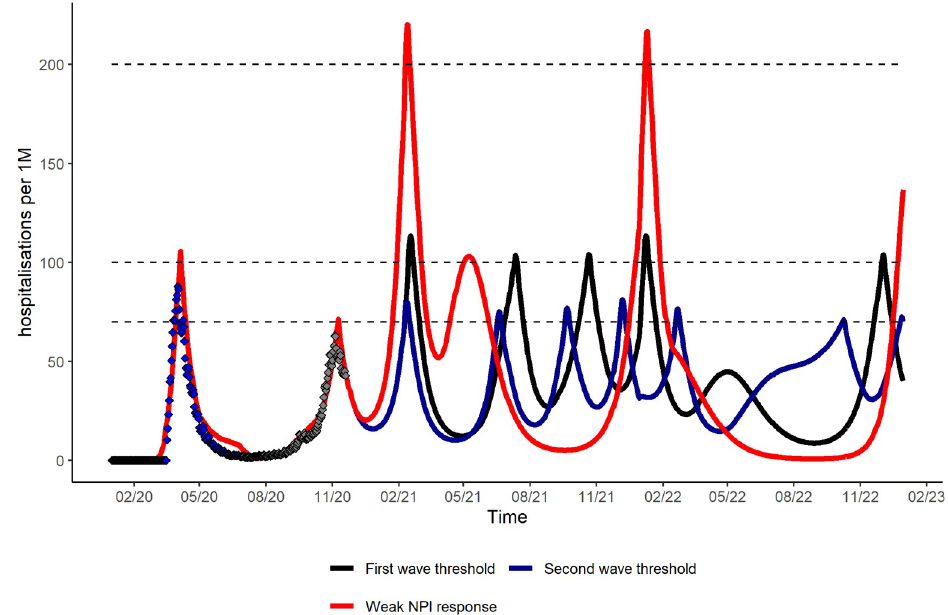
Fig 1. Daily hospitalization incidence (rate per million population per day) in the absence of vaccination for varying level of public policy response, 2020–2022. Based on reference scenario for seasonal variation in COVID-19 transmission (20%), severity of reinfection (90% less than primary infection), median duration of natural/vaccine immunity of one year and NPIs maintained until end of 2022. Black dotted lines correspond to the predefined hospitalization threshold of public health response. The black curve follows a scenario where the threshold for NPIs is based on the first wave (100 hospitalization per one million population). The blue curve represents a scenario where the threshold for NPIs is based on the second wave (70 hospitalizations per one million population). The red curve represents a scenario where the response is weak and the NPI threshold high (200 hospitalization per one million